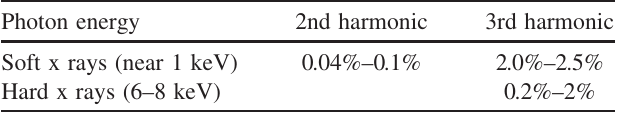
TABLE IV. Summary of harmonic results. The second har- monic content in normal operation at soft x-ray wavelengths is below 0.1%. The third harmonic content is as high as about 2% at normal operation, but can drop by an order of magnitude or more due to poor electron beam quality.